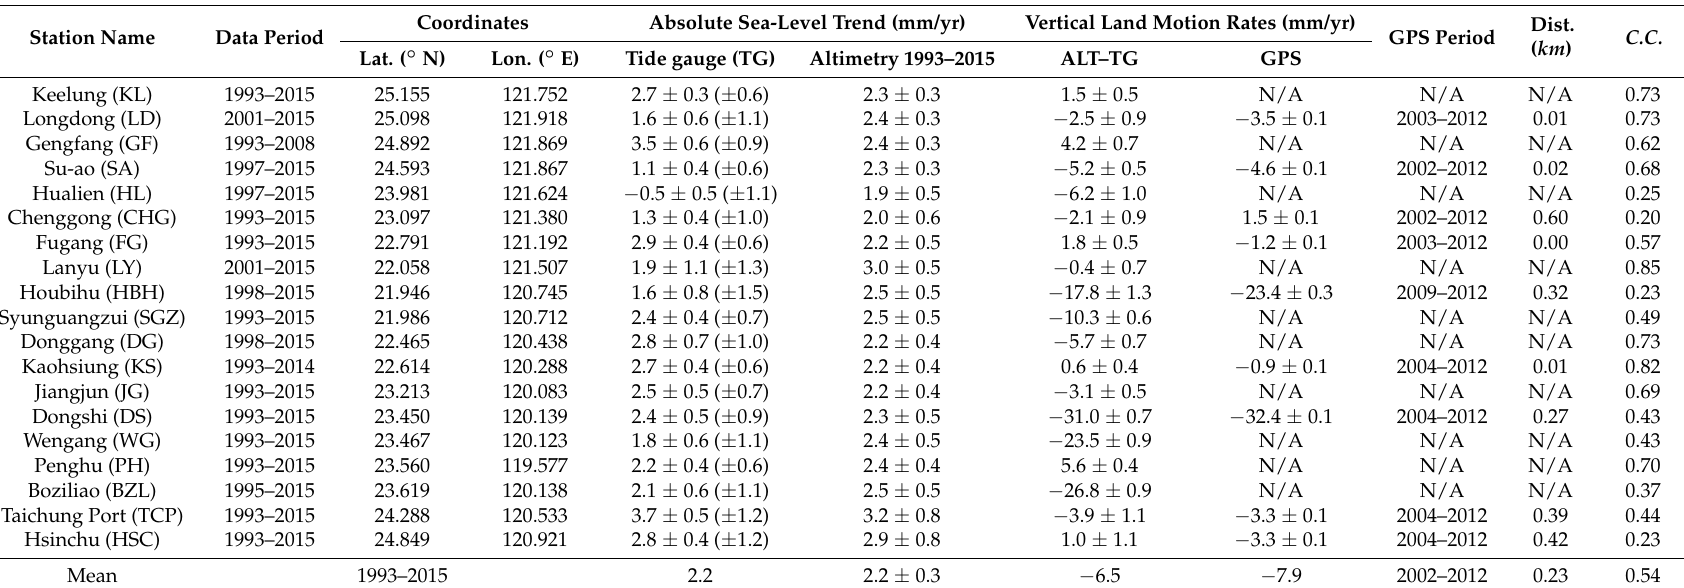
Table 1. Absolute sea-level trends and vertical motion rates obtained in this